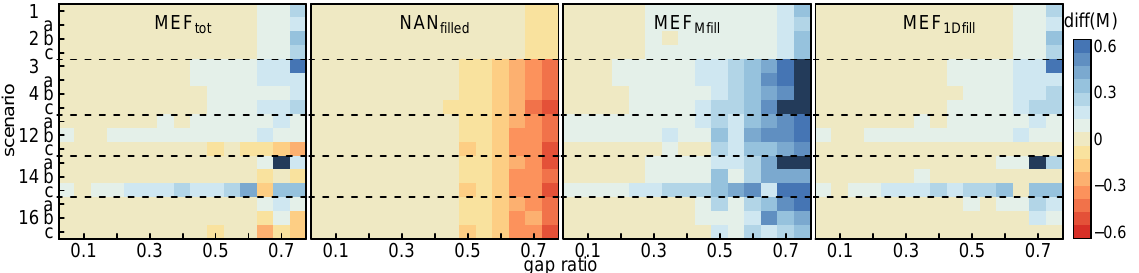
Fig. 7. Prediction performance of the spatiotemporal gapfilling scheme in comparison to state-of-the-art (1-D temporal) SSA methods for the different scenarios ( y axis) as a function of the gap ratio ( x axis). Shown is the difference (1-D temporal – 2-D spatiotemporal) for the different MEF measures (cf. Sect. 2.5). Red colours of increasing intensity indicate higher values for the temporal, and blue colours indicate higher values for the spatiotemporal scheme.